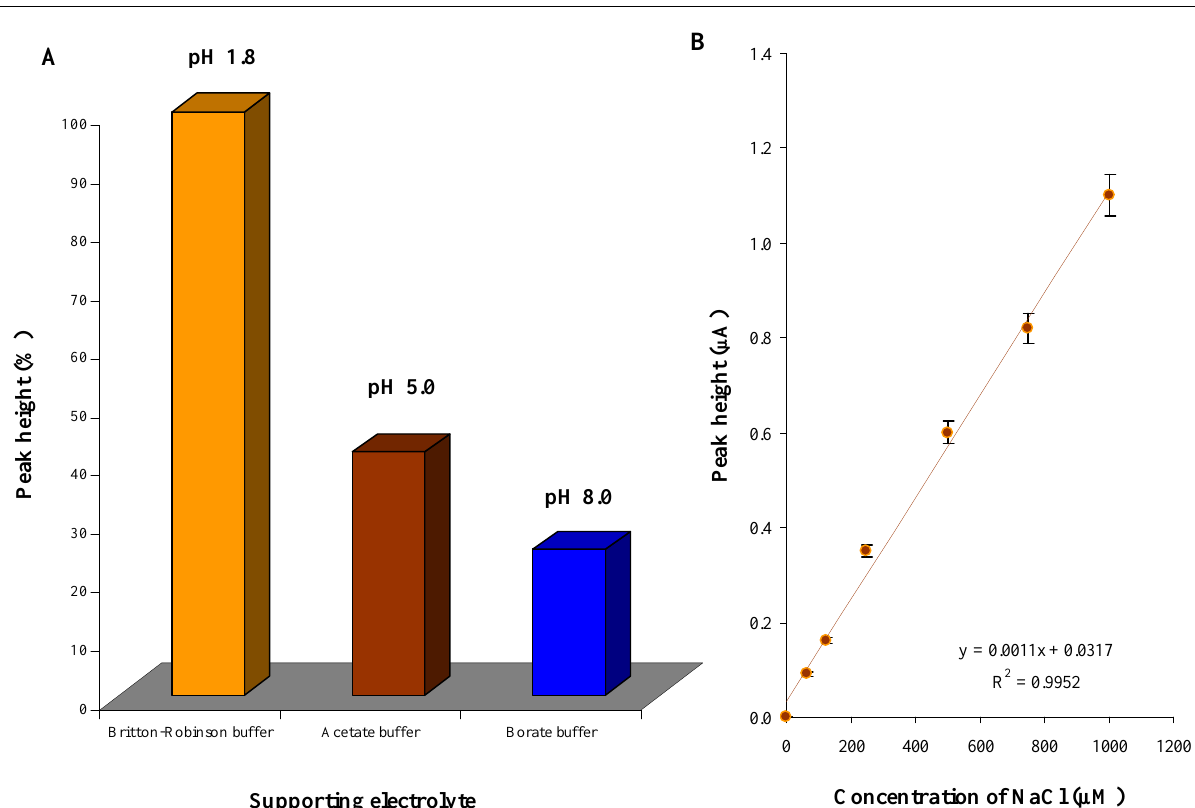
Figure 4. Electrochemical analysis of chloride ions using CPE modified with silver microparticles. ( A ) Effect of type of supporting electrolyte (Britton-Robinson, Acetate and Borate buffer) on chloride ions response. ( B ) Calibration